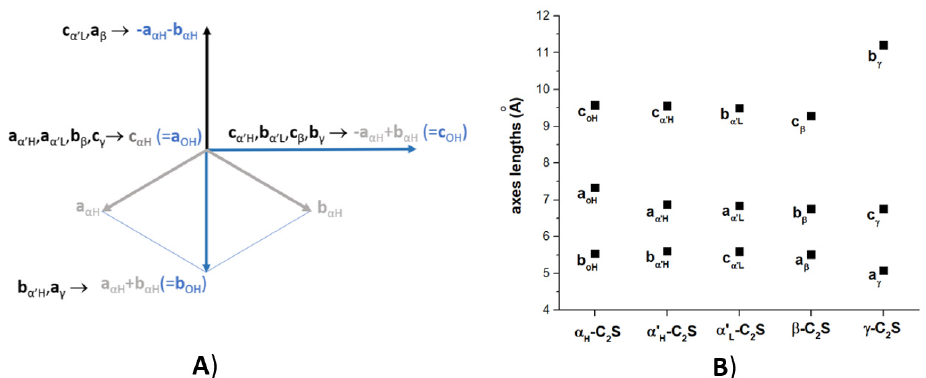
Figure 7. ( A ) The unit cell vector relations for the ortho-hexagonal axes ( a oH , b oH , c oH = − a α H + b α H ) with those of the hexagonal axes of α H -C 2 S polymorph ( a α H , b α H and c α H ) are shown: a oH = c α H , b oH = a α H + b α H and c oH = − a α H + b α H . The correspondence of the unit cell axes for the different polymorphs are also indicated. ( B ) Variation in unit cell values for all polymorphs of belite. The correspondences of the values for the axes of all the polymorphs with those of ortho-hexagonal cell of α H -C 2 S polymorph are given in Table 2.